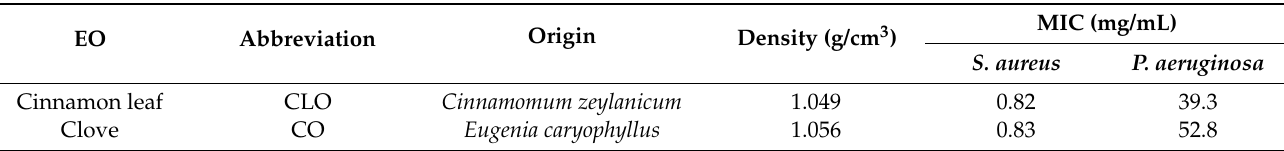
Table 1. List of tested EOs, their origin, density, and MIC values in relation to tested S. aureus and P. aeruginosa refer- ence